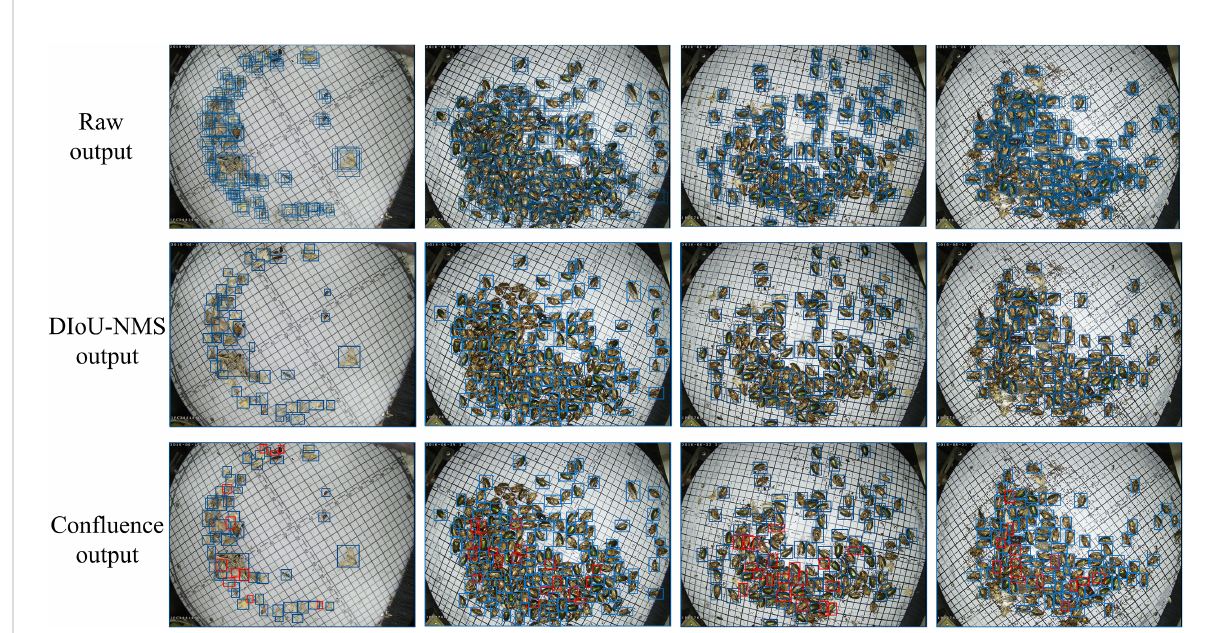
FIGURE 6 YOLOv4 raw output, the DIoU-NMS output, and the con fl uence strategy output of four images. Blue rectangles represent bounding boxes; red rectangles represent bounding boxes suppressed by the